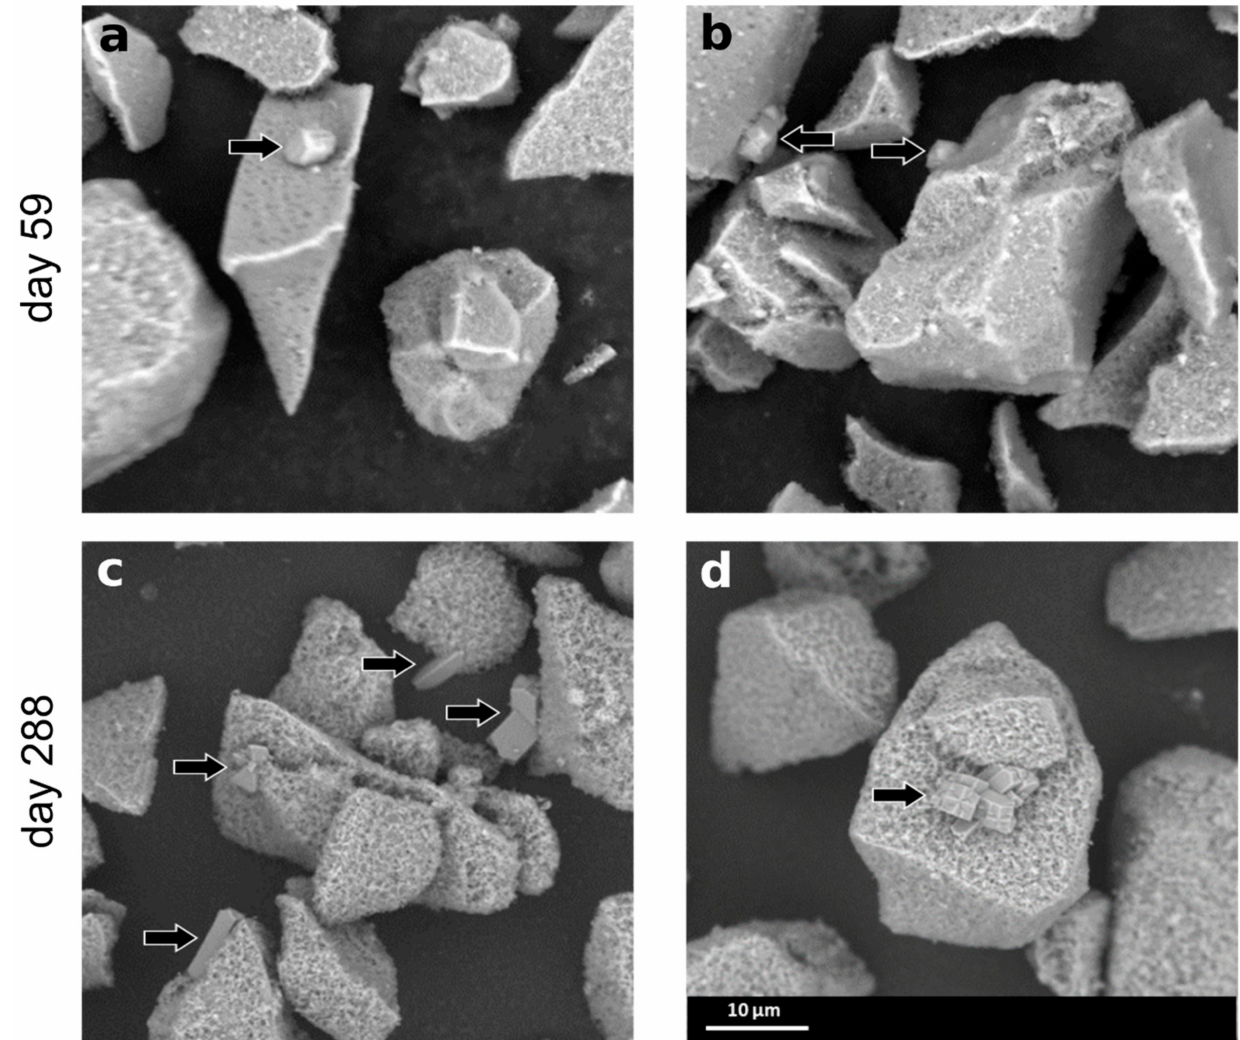
Figure 4. SEM-SE images of altered glass samples after 59 ( a , b ) and 288 days ( c , d